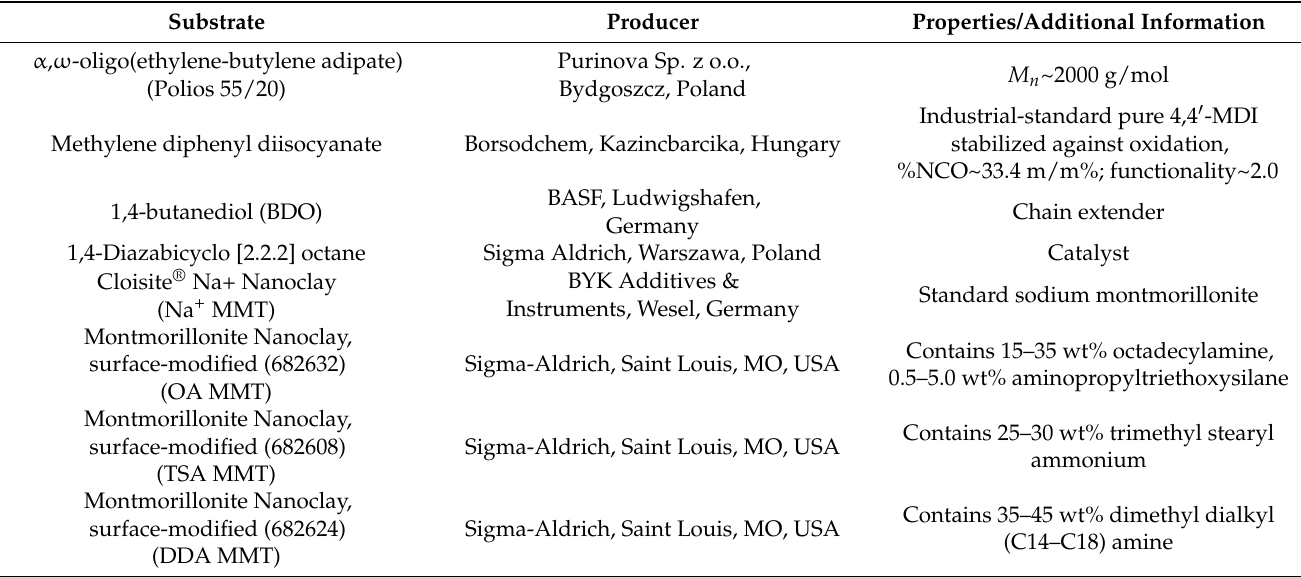
Table 2. Substrates for manufacturing of PU and PU